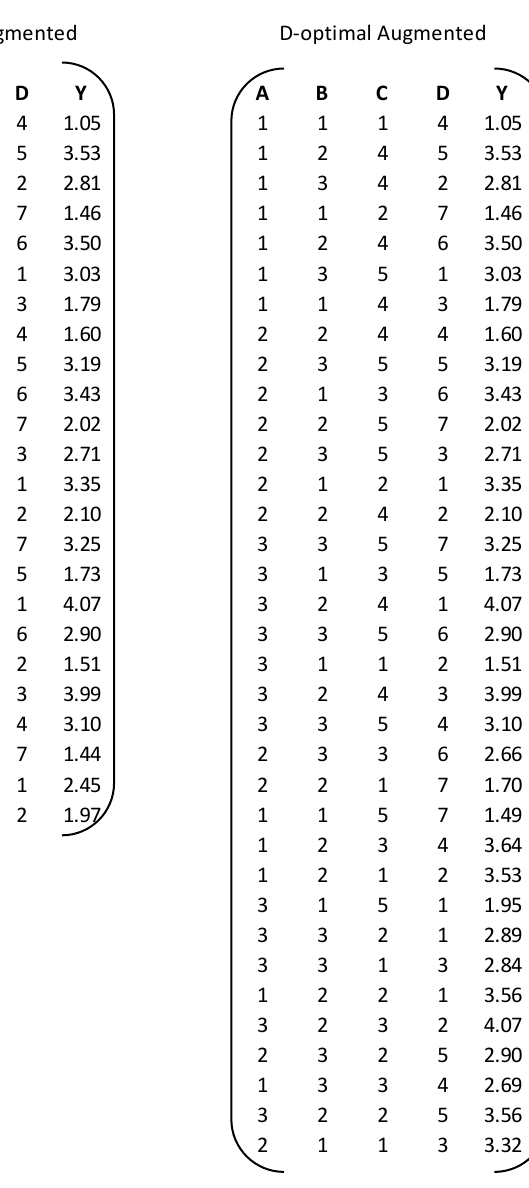
Figure 18. Alias structures for original, sequentially augmented, and D-optimal augmented designs.